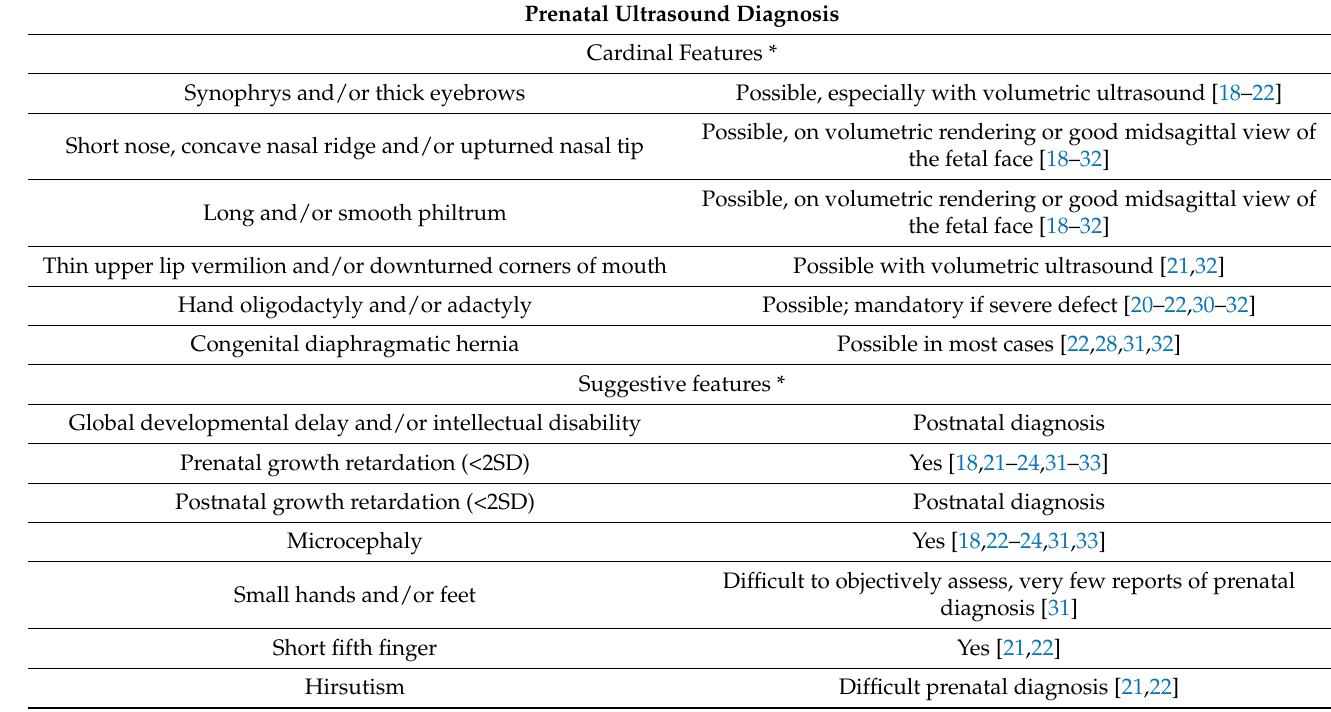
Table 1. Prenatal ultrasound diagnosis of cardinal and suggestive features of Cornelia de Lange Syndrome. Prenatal Ultrasound